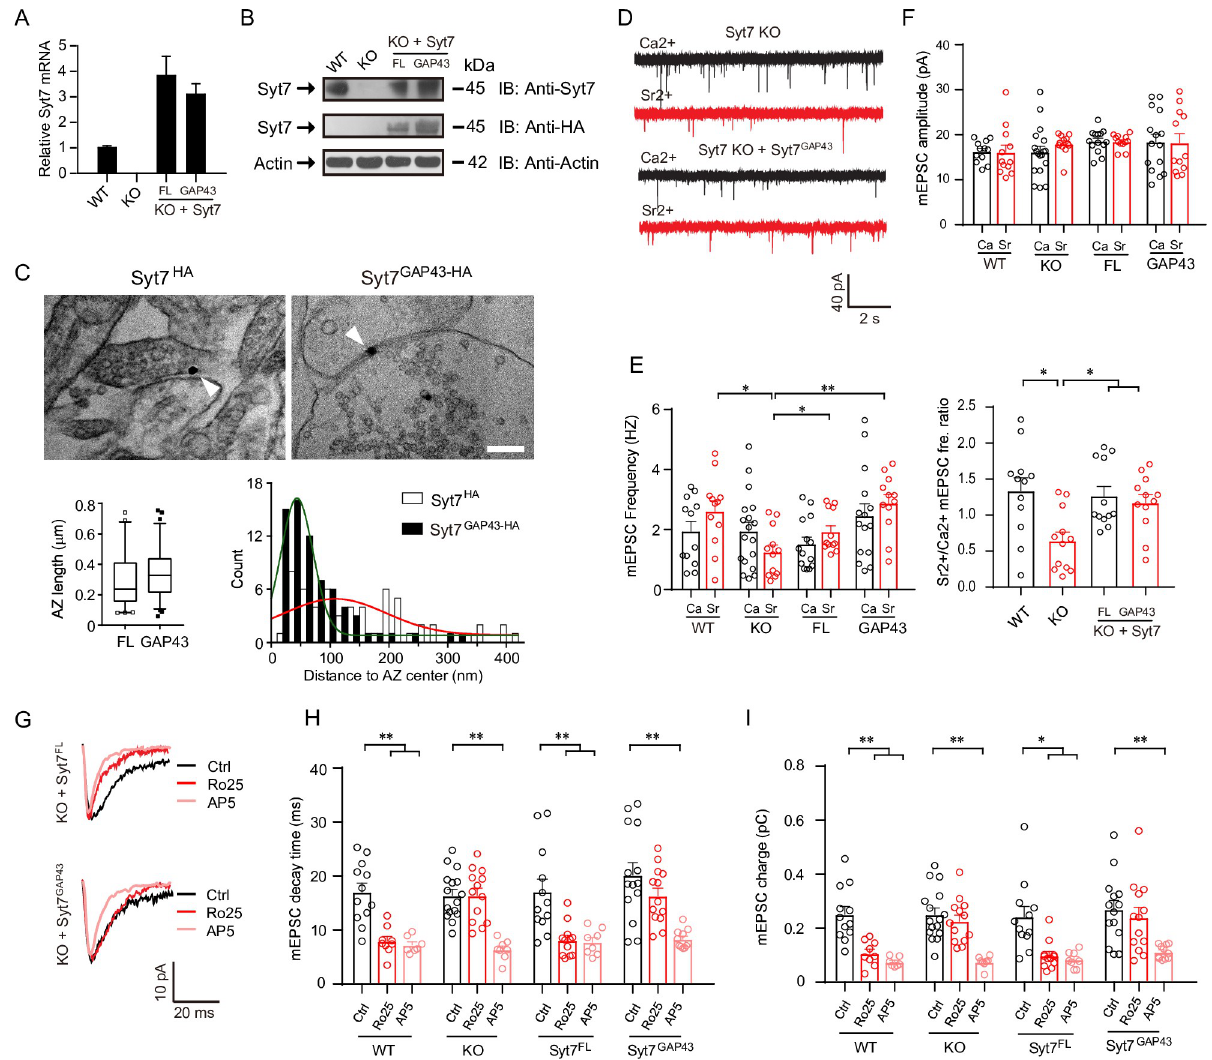
Fig 3. Retargeting Syt7 to the central AZ triggers non-GluN2B spontaneous neurotransmission. ( A, B ) qRT-PCR ( A ) and IB ( B ) analyses showing the lentiviral expression of HA-conjugated Syt7 in neurons. ( C ) EM analysis showing that Syt7 GAP43 -HA ( n = 69) was closer to the center of AZ compared to Syt7 FL -HA ( n = 59). Upper, sample EM images. Scale bar, 200 nm. Lower left, AZ length. Lower right, histogram of Syt7 FL -HA/ Syt7 GAP43 -HA distribution. Red and green curves are fitted Gaussian curve. ( D ) Sample traces of Ca 2+ /Sr 2+ -triggered mEPSCs in WT neurons ( n = 12/ 12), Syt7 KO neurons ( n = 18/12), and KO neurons expressing Syt7 FL ( n = 14/12) or Syt7 GAP43 ( n = 15/12). ( E ) Analysis of mEPSC frequency (left) and Sr 2+ /Ca 2+ ratio of frequency (right). WT, n = 12/12; KO, n = 18/12; Syt7 FL , n = 14/12; Syt7 GAP43 , n = 15/12. ( F ) mEPSC amplitude. ( G ) Average traces showing the kinetics of AMPAR/NMDAR-mEPSCs in Syt7 GAP43 -expressing neurons following GluN2B blockade. ( H, I ) Decay time ( H ) and total charge ( I ) of mEPSCs. WT, n = 12/9/7; KO, n = 16/13/8; Syt7 FL , n = 12/12/8; Syt7 GAP43 , n = 14/13/11. ANOVA (see S6 Fig); � P < 0.05; �� P < 0.001; error bars, SEM. The numerical data underlying this figure are included in S1 Data. AMPAR, AMPA receptor; AZ, active zone; EM, electron microscopy; FL, full-length; IB, immunoblot; KO, knockout; mEPSC, miniature excitatory postsynaptic current; qRT-PCR, quantitative reverse transcription PCR; Syt7, synaptotagmin-7; WT,